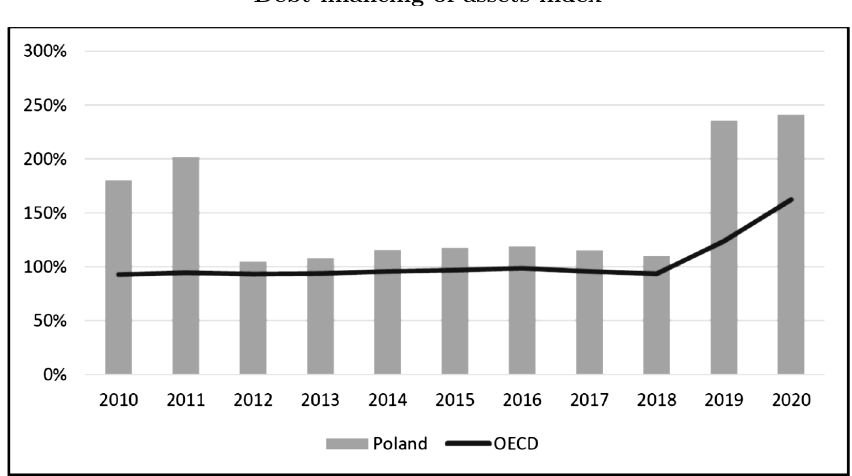
Debt financing of assets